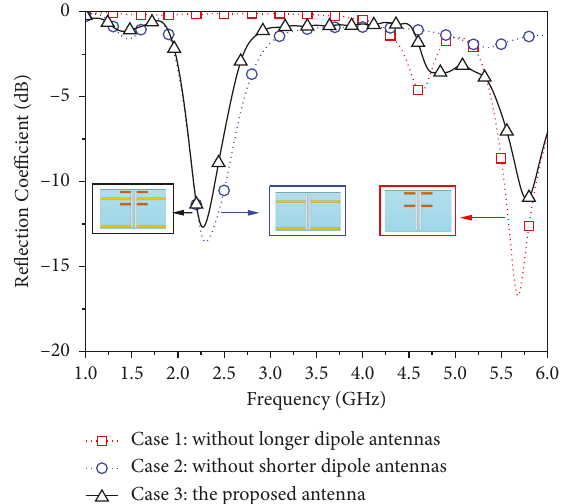
Figure 3: Simulated reflection coefficients of different cases (case 1: without longer strips; case 2: without shorter strips; and case 3: proposed antenna).